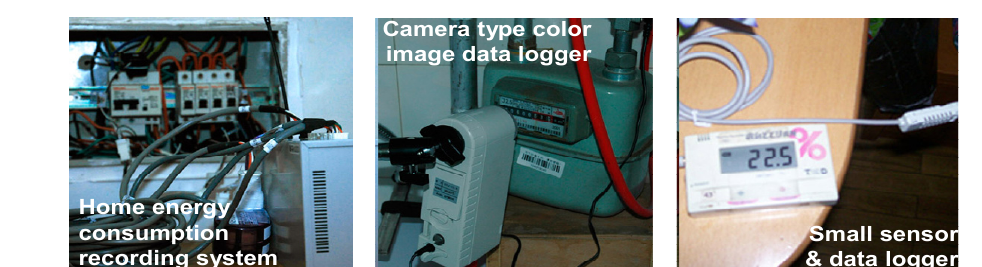
Figure 2. Measurement